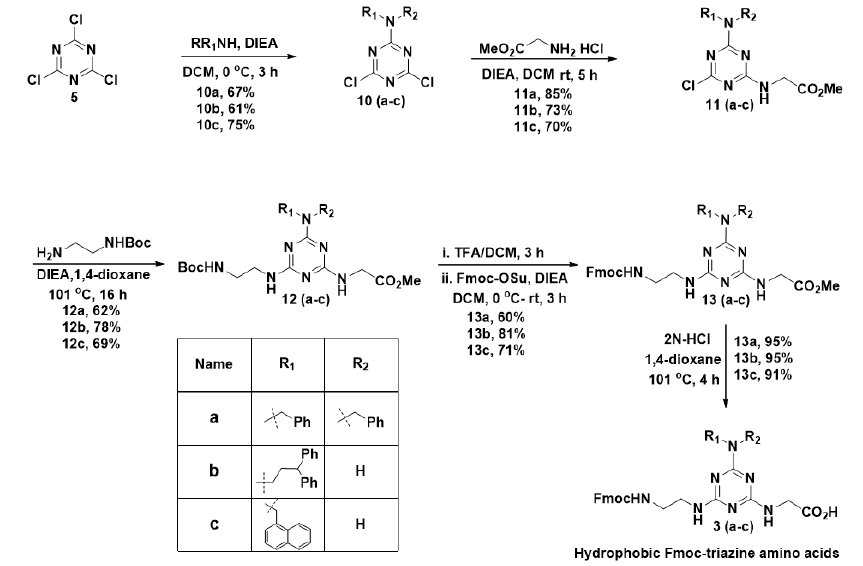
Scheme 1: Synthesis of cationic Fmoc-triazine amino acid